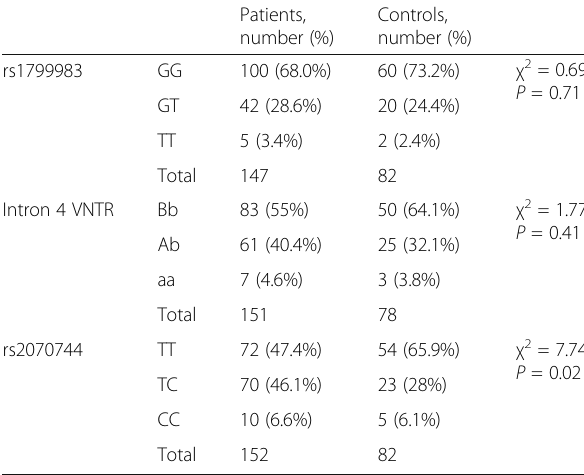
Table 3 Genotype distribution of the three NOS3 polymorphisms among patient and control groups Patients, number (%)